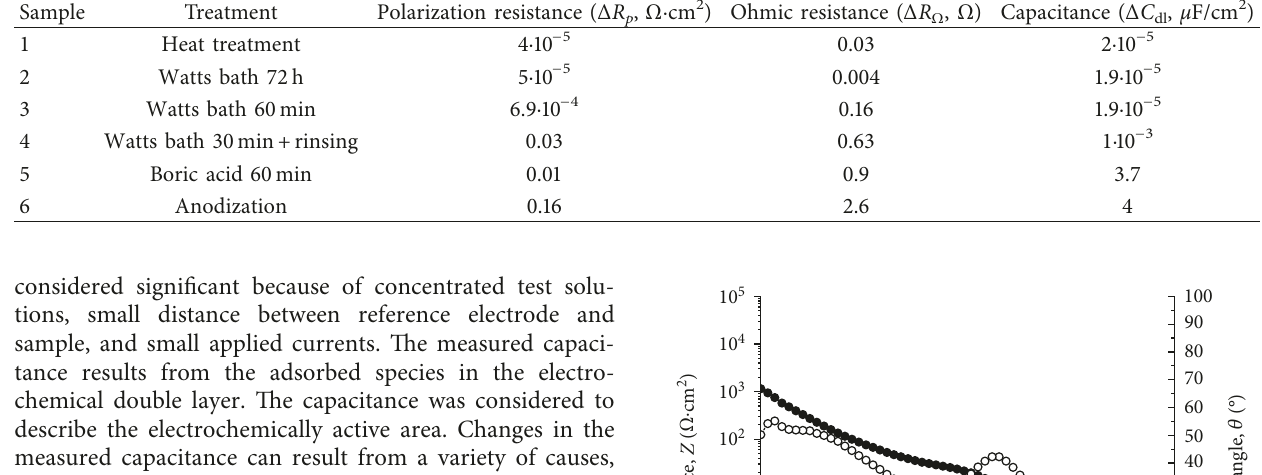
Table 3: EIS measured relative changes in polarization resistance, ohmic resistance, and capacitance of CNT fiber samples after treatments. Sample Treatment